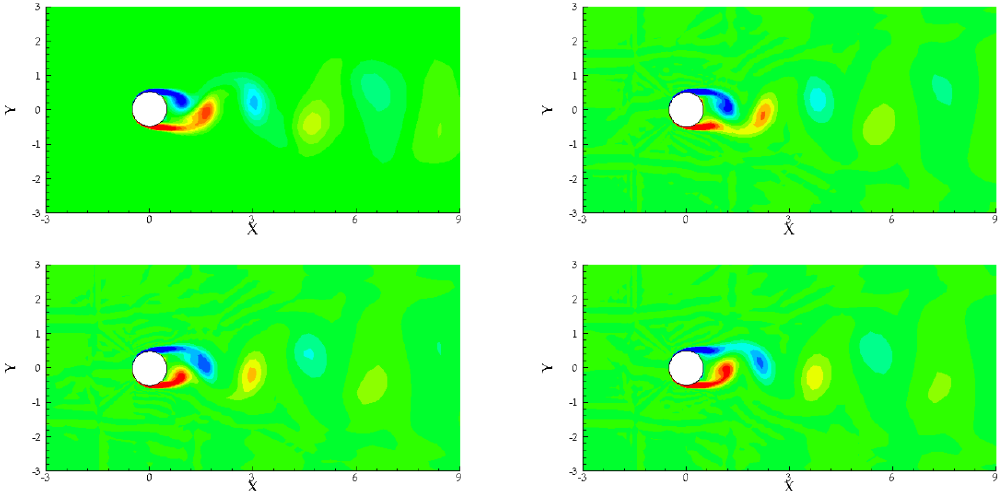
Figure 8. Vibration mode and wake vortex shedding mode of SFT in one cycle when reduced velocity U r = 5.0 (Re = 50,000, m * = 2.5, ξ = 0.007).